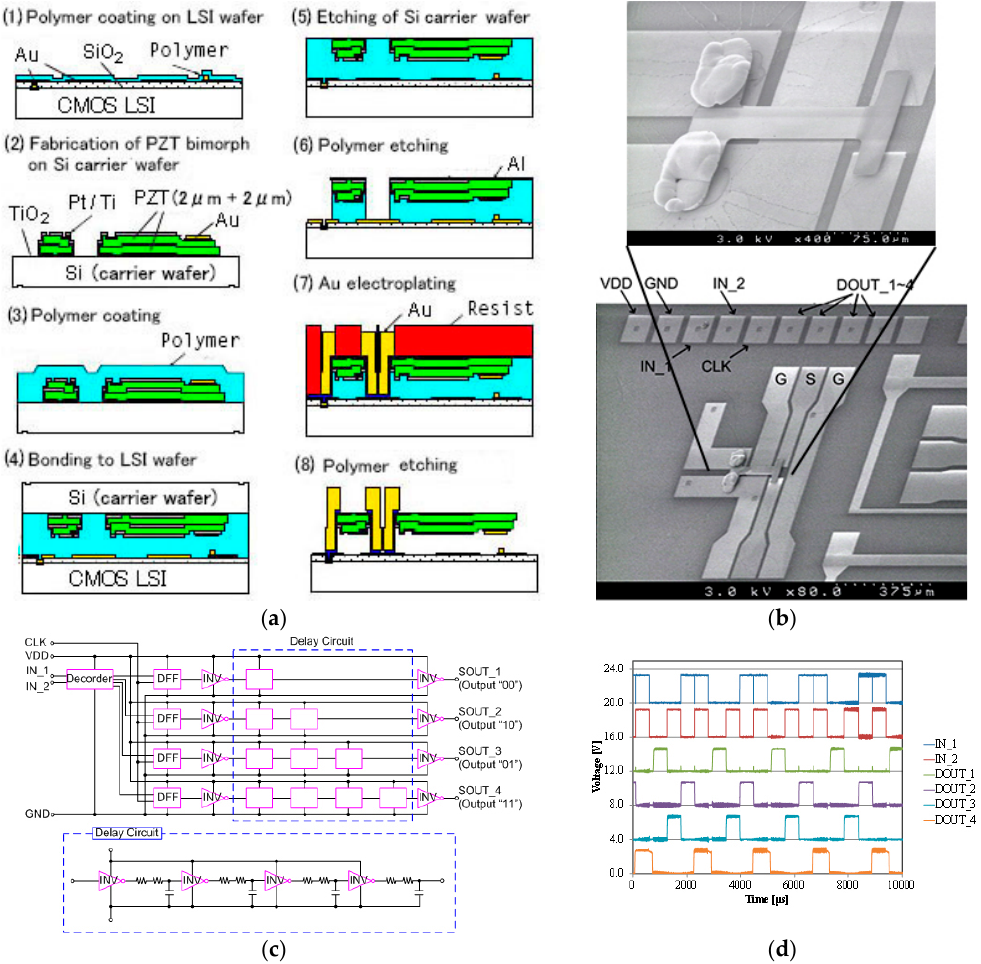
Figure 5. PZT MEMS switch on LSI; ( a ) fabrication process; ( b ) photographs; ( c ) circuit; and ( d ) waveform from the circuit.